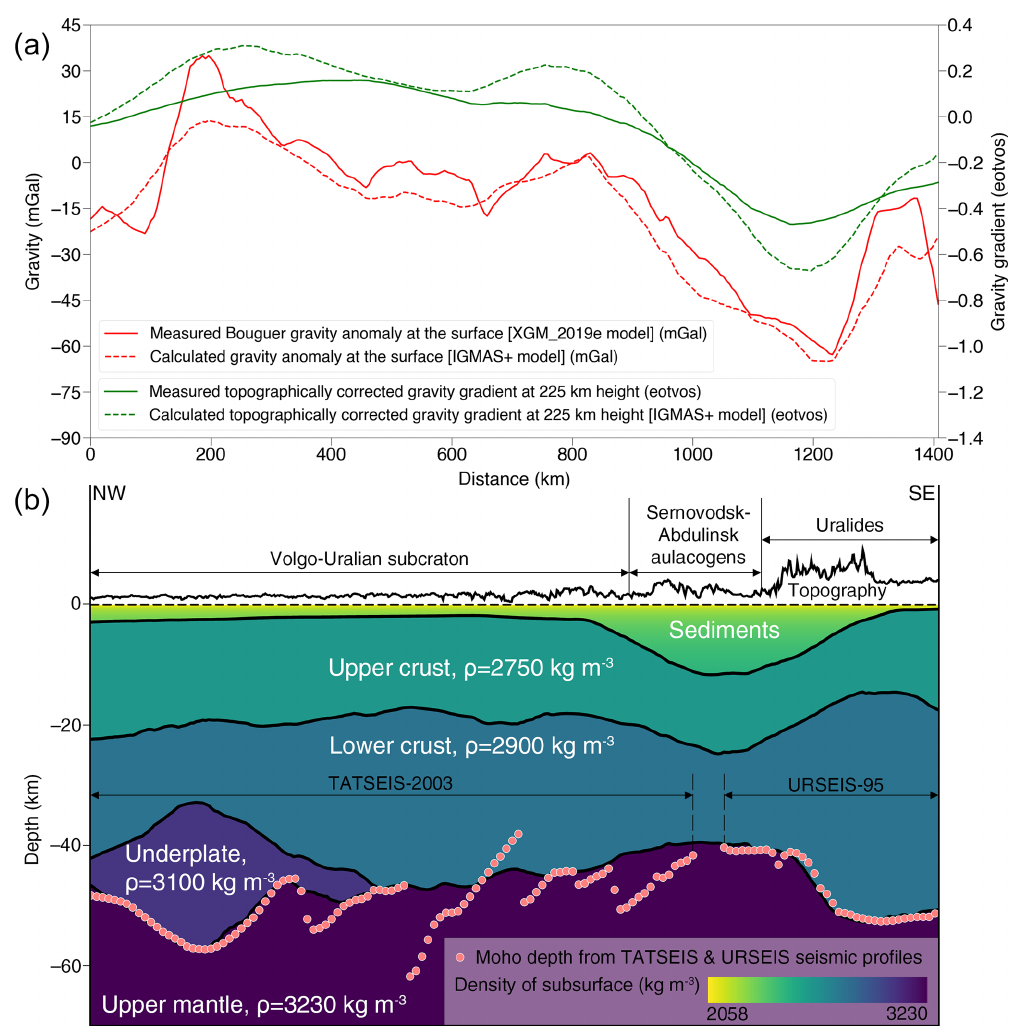
Figure 12. Measured and calculated Bouguer gravity anomalies and the topographically corrected vertical gravity gradient anomalies from the crustal model (a) and IGMAS + model cross-section along TATSEIS-2003 and URSEIS-95 deep reflection profiles (b) – see Fig. 3 for the reference on the map. Subsurface is vertically exaggerated by the factor of 10 and topography is by the factor of